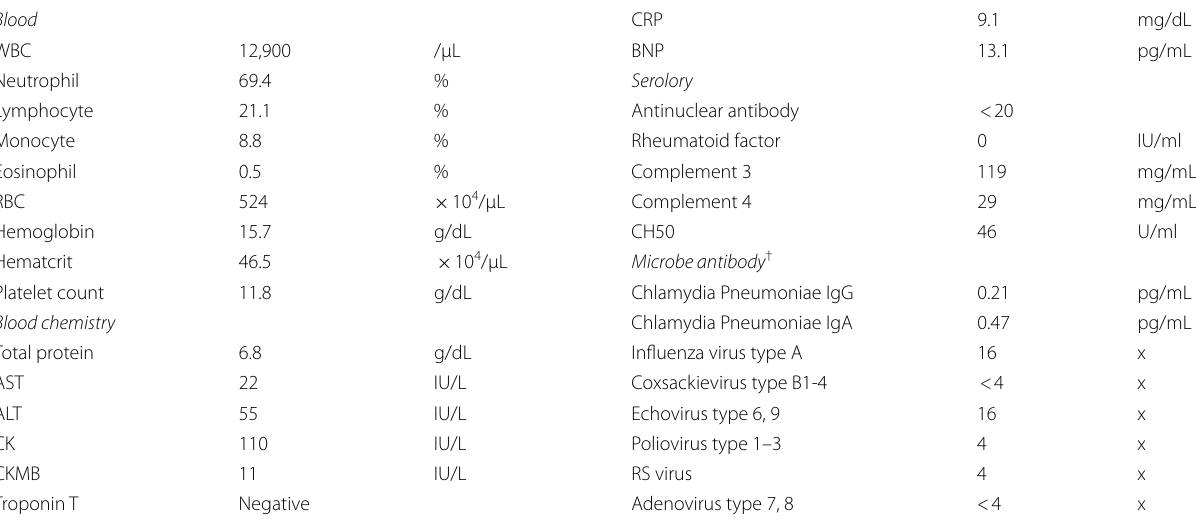
Table 1 Laboratory findings at second